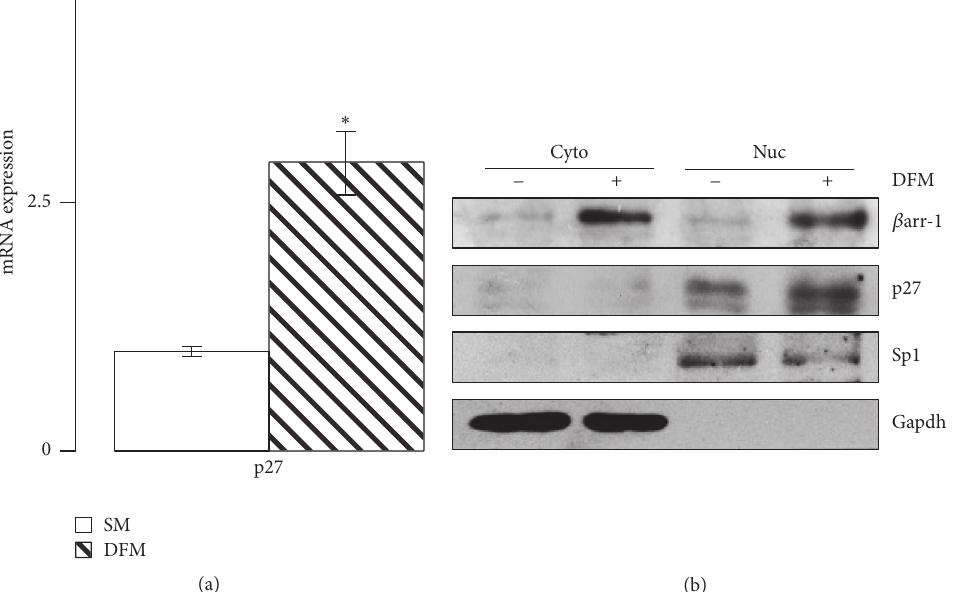
Figure 5: 𝛽 arr-1 controls NSCs proliferation via p27 expression. (a) p27 mRNA expression levels evaluated by qRT-PCR in NSCs grown under stemness conditions (SM) and after differentiation (DFM) for 48 hours. Data are means ± SD from 3 independent experiments. ∗ 𝑝 < 0.05 (DFM versus SM). (b) Western blot showing subcellular localization of endogenous 𝛽 arr-1 and p27 in NSC cultured in SM or DFM for 48 hours. 𝛽 arr-1 and p27 proteins levels were assessed in cytosolic (Cyto) and nuclear (Nuc) fractions. Gapdh and Sp1 protein levels were used as loading controls and markers for purity of Cyto and Nuc fractions, respectively. Representative Western blot images from 3 independent